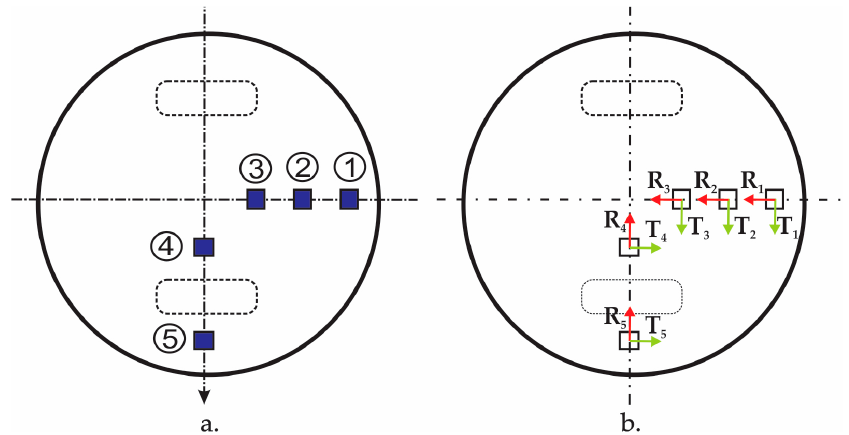
Figure 7. Strain gauges fixed on the bottom of the manhole cover: ( a ) Numbering and positions; ( b ) measuring directions. Table 2. Positions of the strain gauges with respect to the centre of the manhole cover. Number Strain Gage